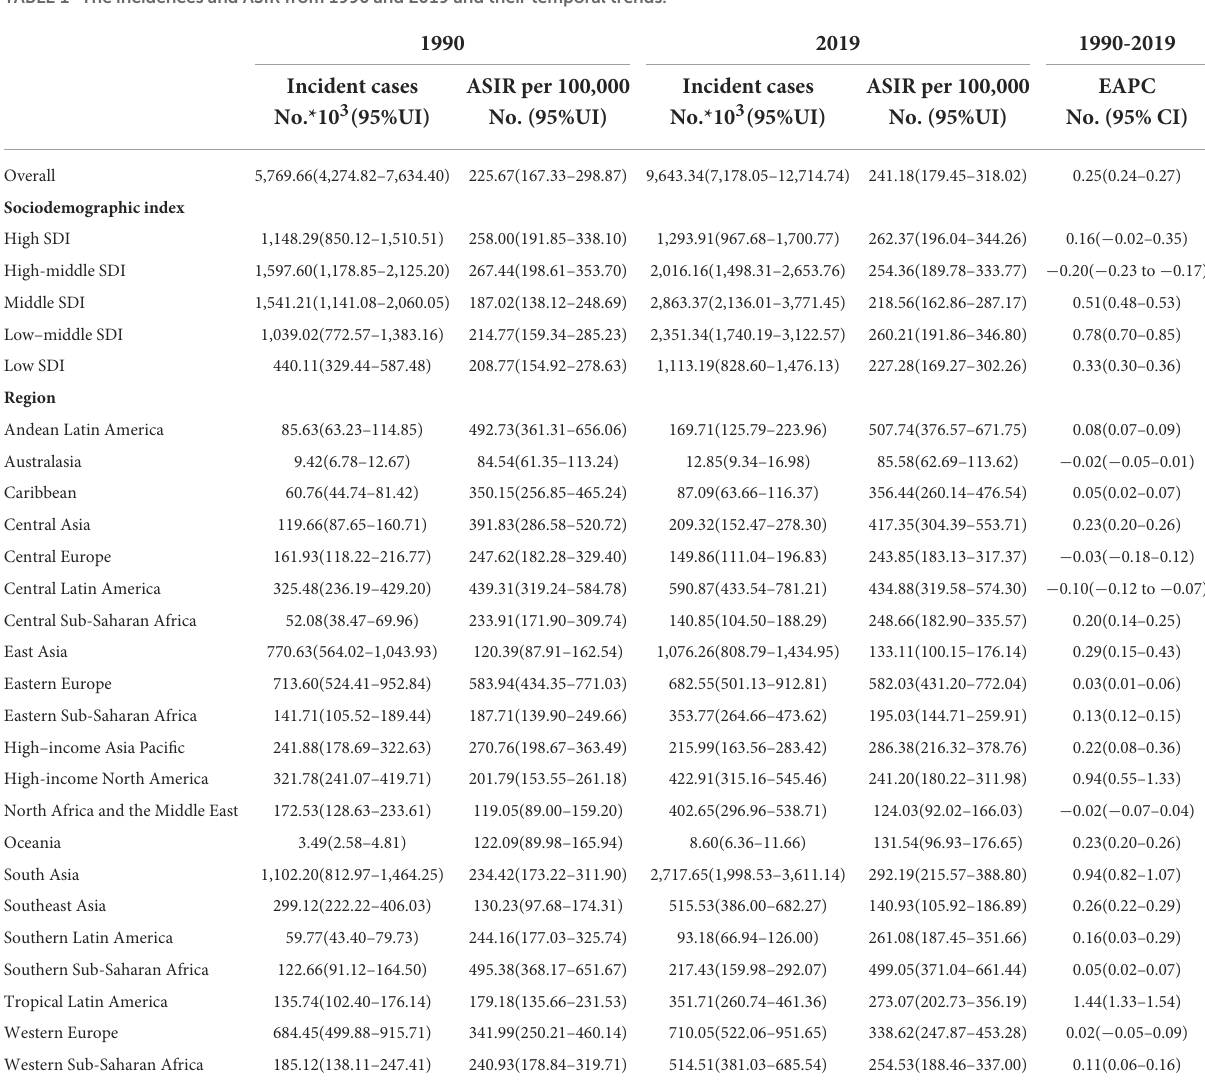
TABLE 1 The incidences and ASIR from 1990 and 2019 and their temporal